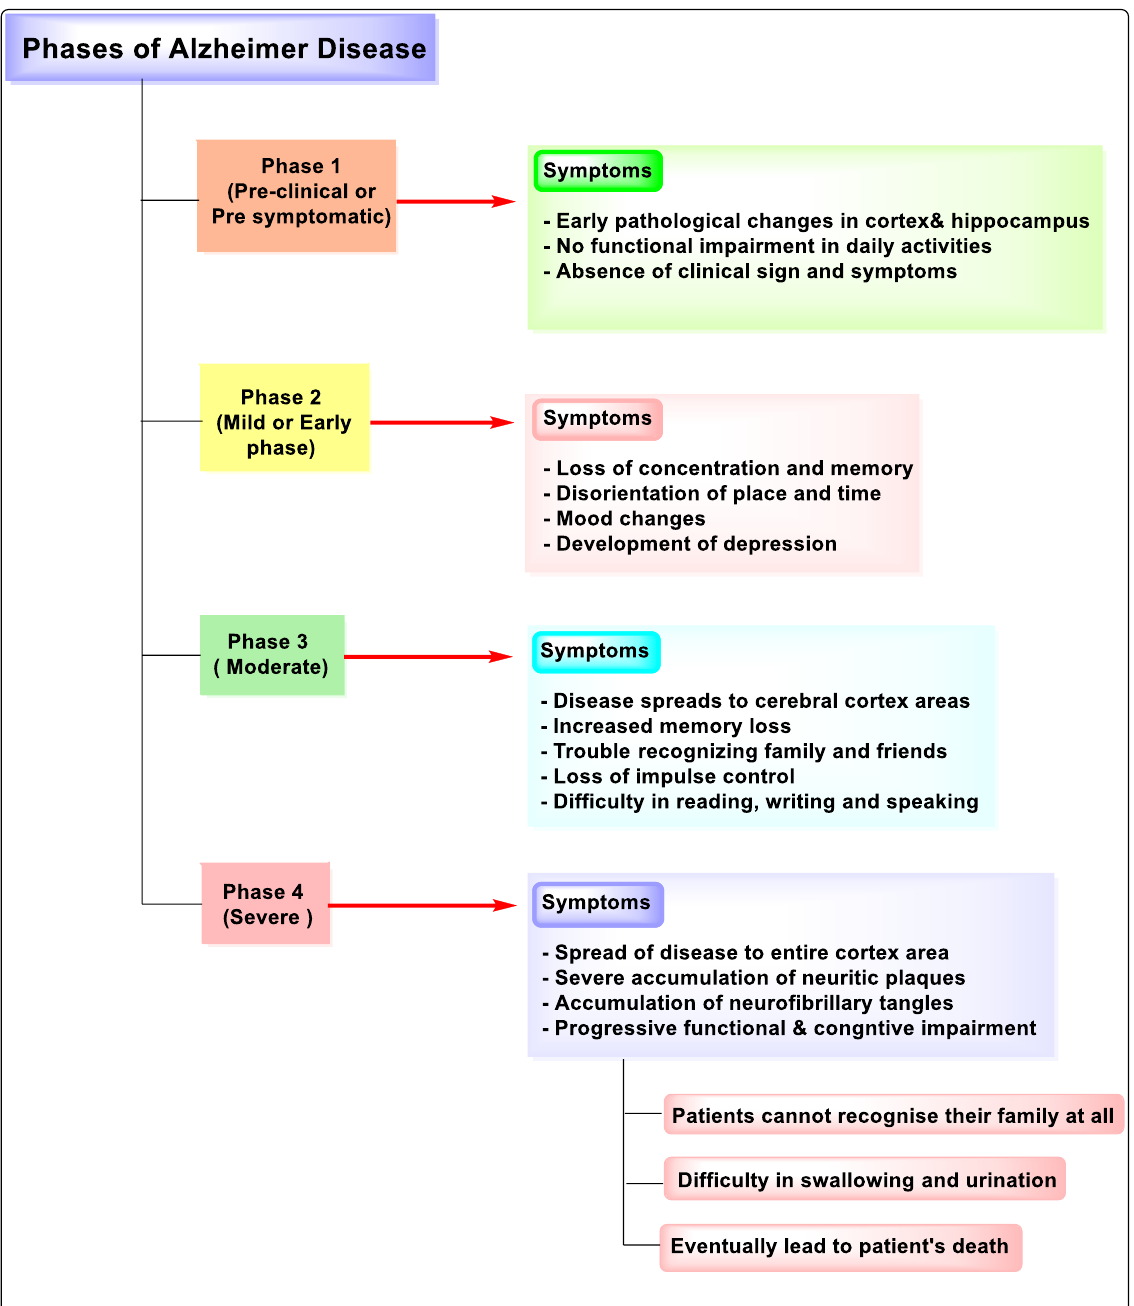
Figure 3. Phases of Alzheimer ’ s disease.